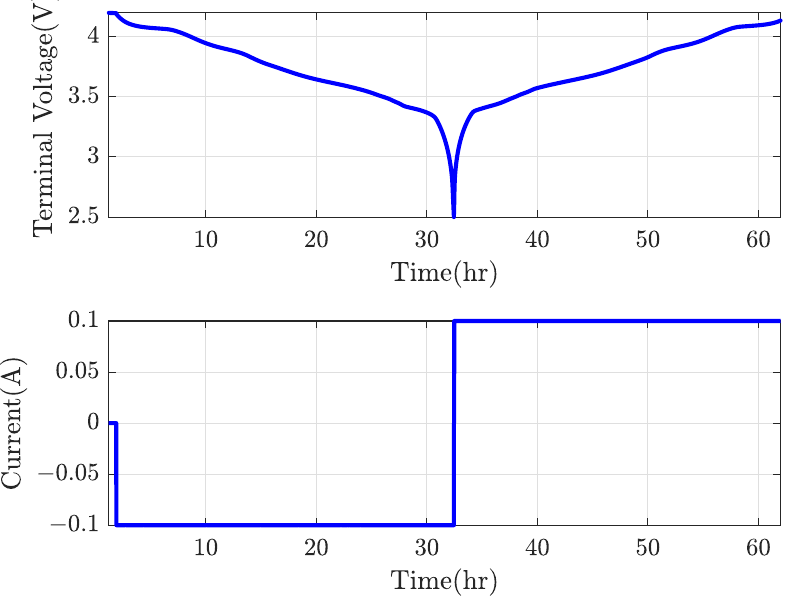
Figure 12. V-I data in OCV test.